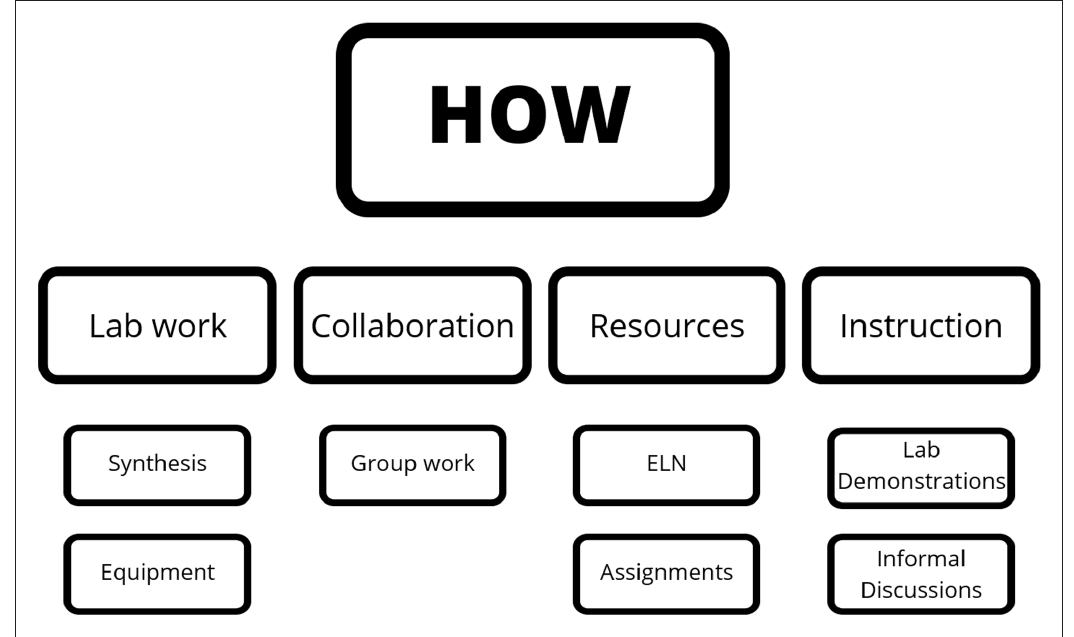
Figure 4 Student experiences of Breaking Good facilitating their